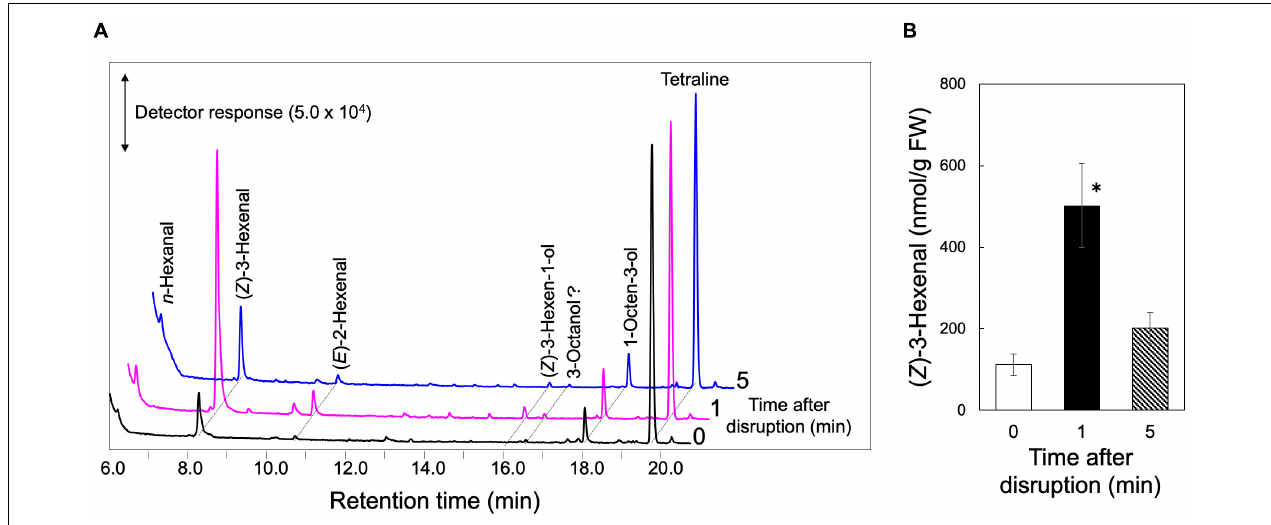
FIGURE 2 | GLV-burst with S. moellendorffii . The upper ground parts of S. moellendorffii were ground in a mortar and pestle. After 1 and 5 min, the volatiles were extracted for GC-MS analyses. Intact leaves were also analyzed and shown at 0 min after disruption. (A) Representative chromatograms of volatiles found in the extracts. (B) The amounts of ( Z )-3-hexenal found in the extracts. Mean values ± SE are shown ( n = 3, biological replicates). Asterisk shows significant differences (one-way ANOVA, Tukey, P < 0.05).